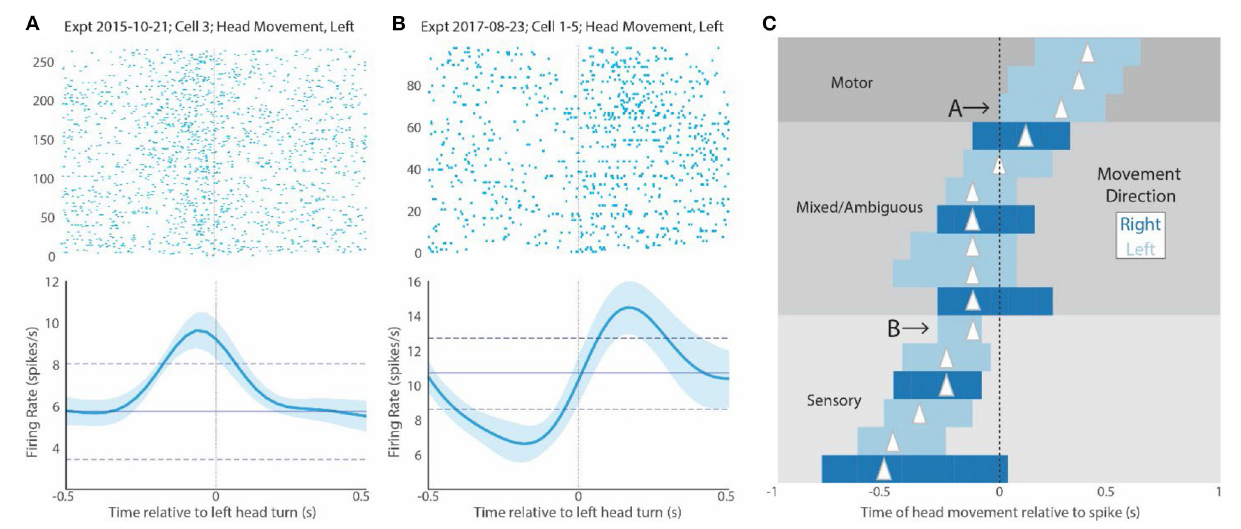
FIGURE 4 | CX activity relative to mantis movement. (A) Raster plot of several responses associated with head movement of any kind for a sample cell. The 0 point here indicates the beginning of the head movement. The plot underneath shows the mean and SD firing response of all trials in the raster display. Note that the peak firing precedes the head movement, suggesting that it could contribute to driving the movement. (B) Shows a similar display for another cell that responds after the head movement (to the right of 0). This suggests that this cell responds to either proprioceptive or visual inputs associated with the turn or corollary discharge of the motor commands. (C) Shows bars indicating the peaks of STRF plots for all cells that were above 2 SDs. As in Figure 3B , the length of the bar indicates duration above 2 SDs, and the triangle indicates the peak of the curve. Dark blue bars are associated with rightward head movements, and light bars are associated with leftward head movements. In this display, bars to the left of 0 indicate regions where head movement precedes increase in spiking (0 point). We have labeled bars that are complete in this region as “sensory.” In contrast, bars to the right of 0 indicate responses where increases in spike activity (0 point) precede movement. We have labeled bars that are complete in this region as “motor”. Bars that span both regions relative to the 0 point are labeled mixed or ambiguous. They could be involved in both motor and sensory effects. Cells whose activity is displayed in (A,B) are indicated with letters and arrows. Note that the relationship of the STRF plots relative to the 0 point is the opposite of that seen in the rasters. That is because the 0 point in the STRF plots indicates the point where spike activity increases, whereas the 0 point in the raster display is the point where movement